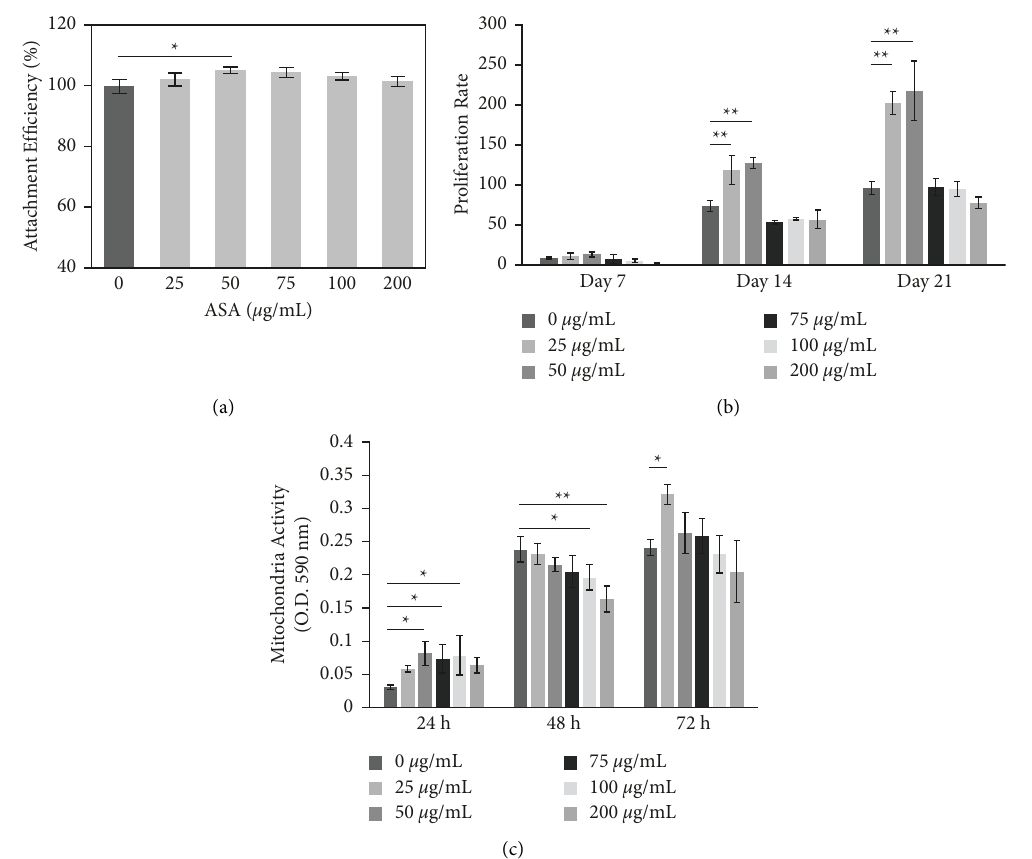
Figure 3: Acetylsalicylic acid (ASA) treatment showed no cytotoxic effect on human dental pulp cells (HDPCs). (a, b) Crystal violet staining solubilized by triton X-100 showed significantly higher attachment efficiency of HDPCs-treated with 50 mg/mL ASA than the control at 16h. A significant increase in the proliferation rate was observed in HDPCs treated with low concentrations of ASA (25–50 mg/mL). (c) MTT assay indicated that ASA-treated HDPCs expressed an elevation of mitochondria activity over time, and HDPCs treated with 25 mg/mL ASA showed a significantly higher mitochondria activity at 72h compared to the control. n 6 in each (cid:29)